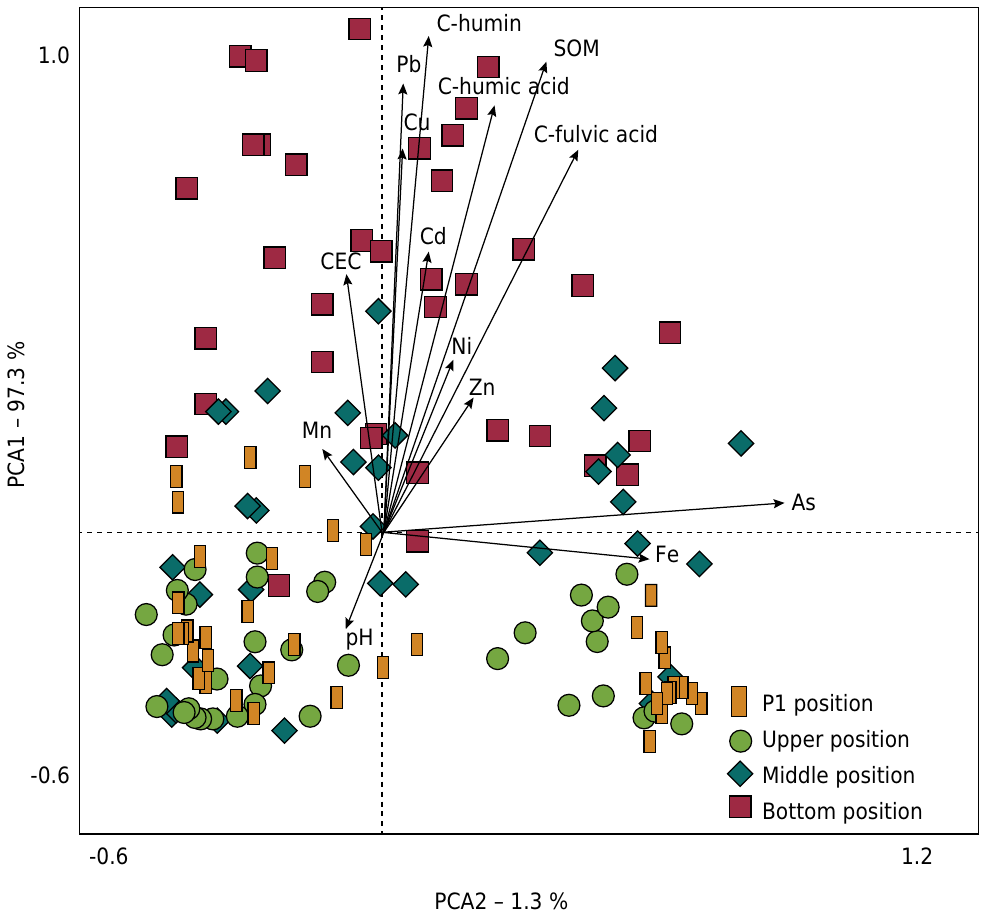
Figure 3. Principal component analysis (PCA) for elemental data distribution and soil properties of the studied